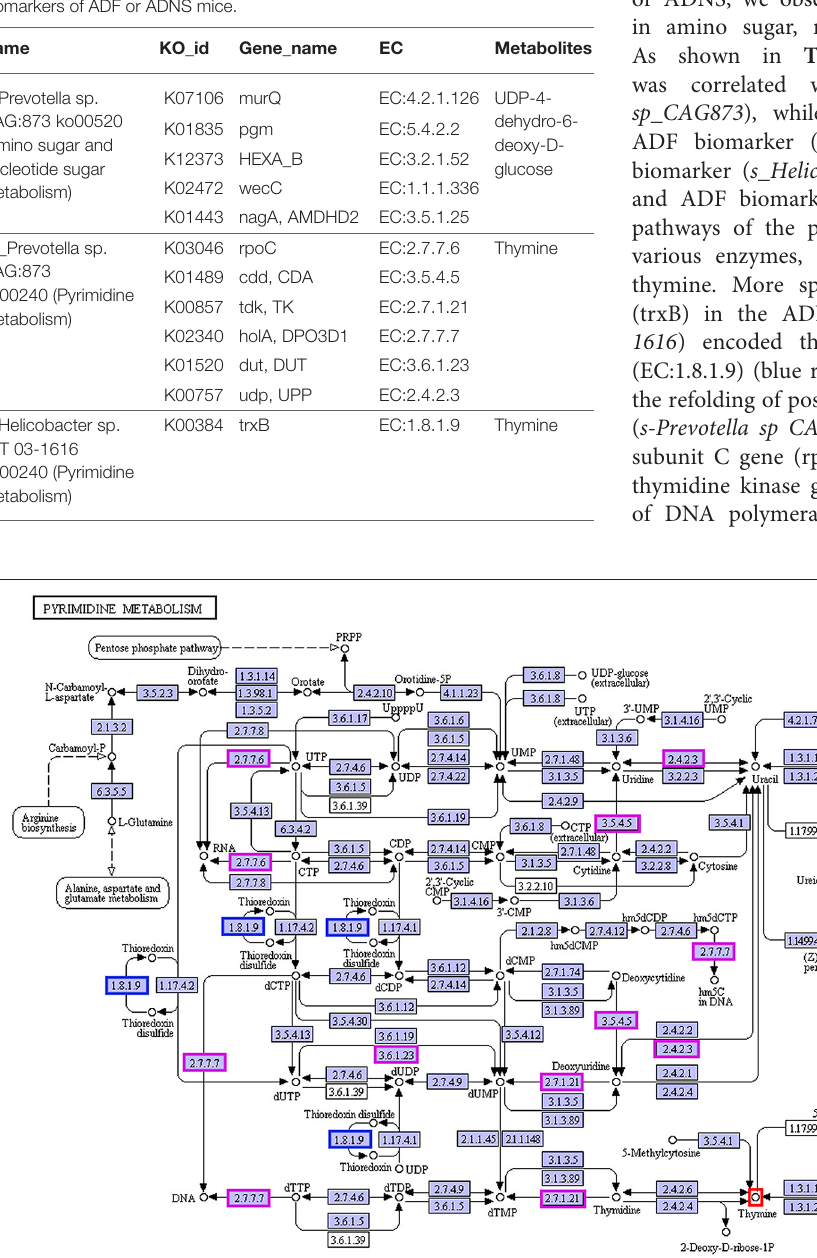
FIGURE 8 | Correlation between thymine and the biomarkers for ADF and ADNS. The enzyme EC:1.8.1.9 (in blue rectangles) encoded by the gene trxB was correlated with the ADNS biomarker ( s_Helicobacter_sp_MIT_03-1616 ), while the enzymes EC:2.7.7.6, EC:3.5.4.5, EC:2.7.1.21, EC:2.7.7.7, EC:3.6.1.23, and EC:2.4.2.3 (in pink rectangles) were encoded by the genes rpoC, cdd/CDA, tdk/TK, holA /DPO3D1, dut/DUT, udp/UPP, respectively; they were correlated with in the ADF biomarker (s-Prevotella sp CAG873) (also see Table 1 for the genes), n = 5. EC:1.8.1.9, thioredoxin-disulfide reductase; EC:2.7.7.6, DNA-directed